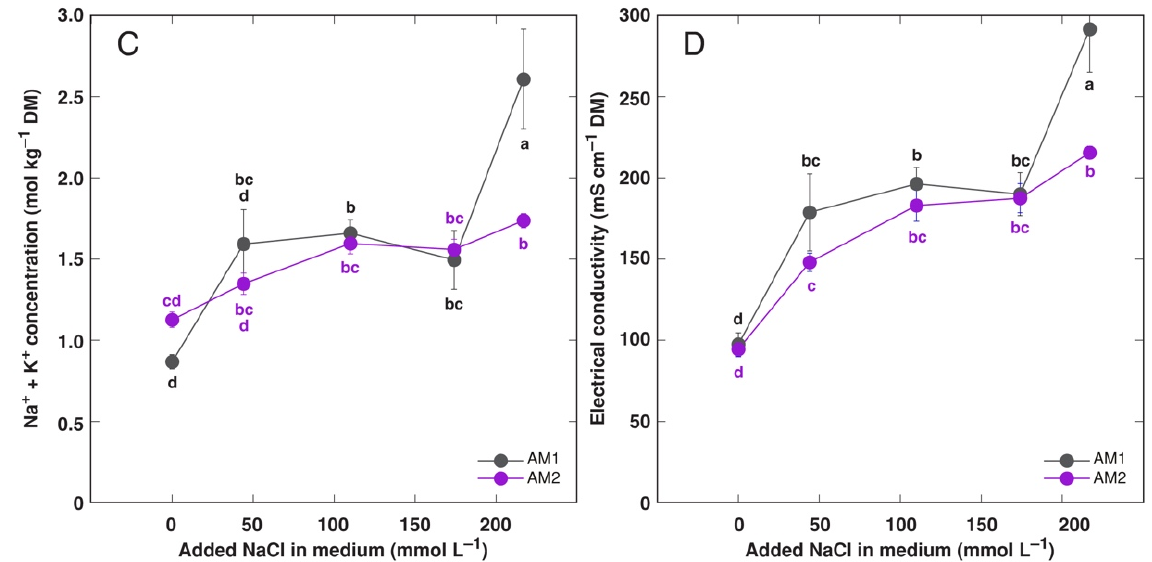
Figure 2. Effect of added Na + concentration in tissue culture medium on Na + concentration ( A ), K + concentration ( B ), summed Na + + K + concentration ( C ) and electrical conductivity ( D ) in explant tissues of Armeria maritima accessions AM1 and AM2 after 4 weeks of cultivation. DM, dry mass. Data are means ± SE from 4–5 replicates. Different letters of respective color between accessions and treatments indicate statistically significant differences ( p < 0.05).